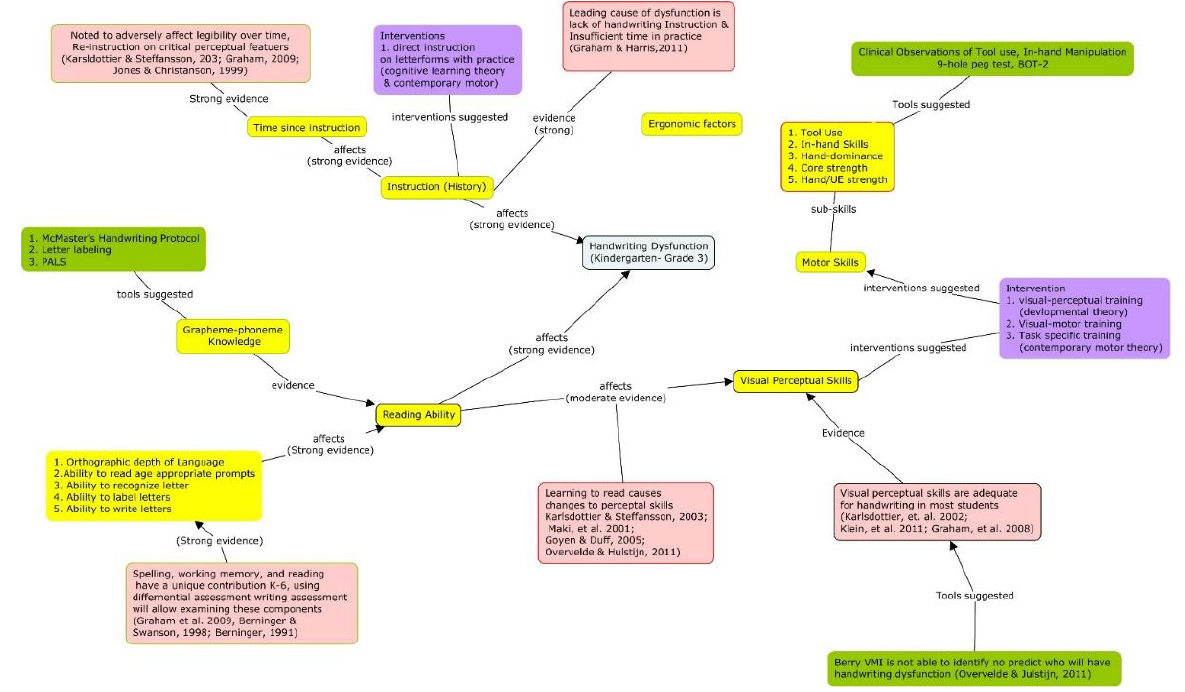
Figure 3. Preliminary causal model after searching the literature. It includes direction of causal relationship and strength of evidence supporting the relationship. Placing the evidence provides ability to confirm appraisal of evidence.